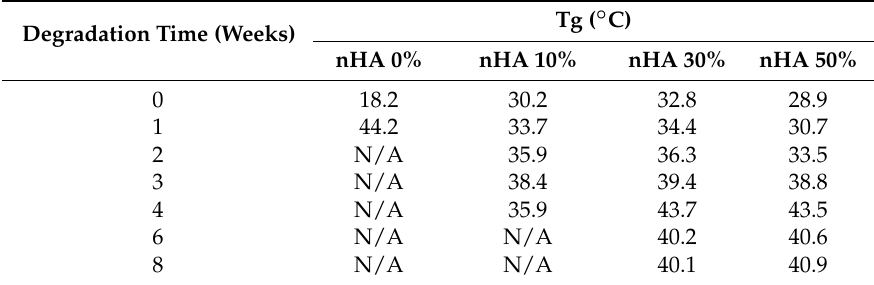
Table 3. Tgs of PLGA (53/47) and PLGA (53/47)/nHA composite scaffolds. Degradation Time